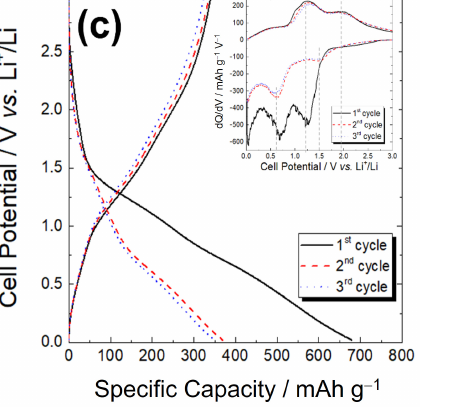
Figure 3. Charge and discharge curves for the first three cycles at a rate of 0.2 C (4.74, 6.38, and 8.84 μ A cm −− 2 ): ( a ) sample P16, ( b ) sample P21, and ( c ) sample P28 (28 at% P). 8.84 µ A cm − 2 ): ( a ) sample P16, ( b ) sample P21, and ( c ) sample P28 (28 at% P).